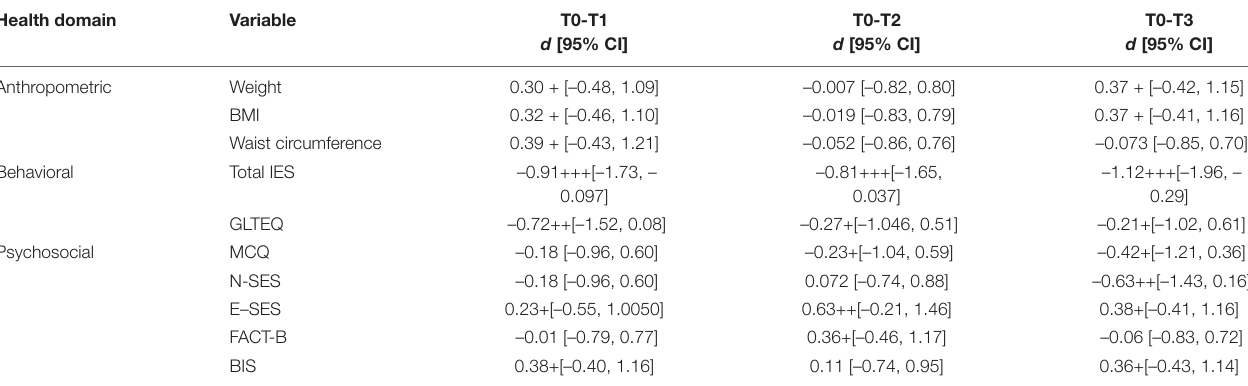
TABLE 4 | Pairwise comparisons of anthropometric, behavioral, and psychosocial outcome scores at baseline (T0) with post-treatment (T1), 6-month follow-up (T2), and 12-month follow- up (T3). Health